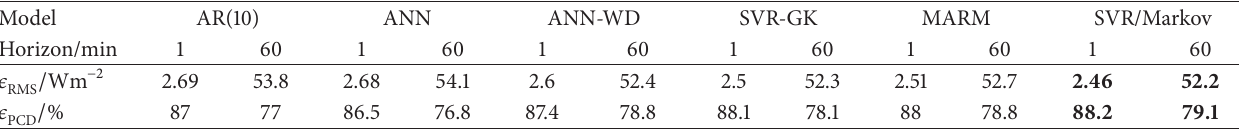
Table 11: Obtained average prediction values for ten days selected from January to February of 2000 ( winter ). Model